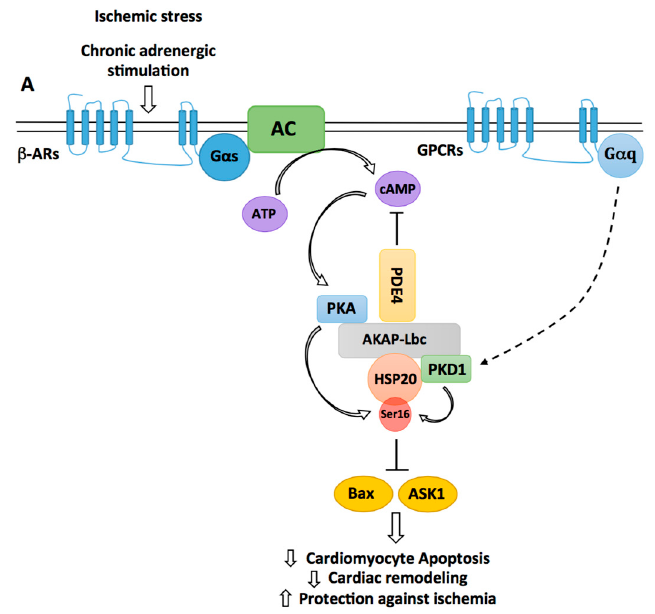
Figure 3. Regulation of HSP20-mediated cardiomyocyte protection by AKAP-Lbc. By recruiting phosphodiesterases 4 (PDE4), AKAP-Lbc maintains a low local concentration of cAMP, which prevents activation of anchored PKA. Chronic β -adrenergic stimulation induces a sustained production of cAMP, which saturates PDE4 and promotes anchored PKA activation. Activated PKA phosphorylates AKAP-Lbc-bound HSP20 on serine 16, an event that has been shown to enhance the cardioprotective function of HSP20. Indeed, phosphorylated HSP20 has been shown to suppress Ask1-dependent signaling and to inhibit Bax leading to reduced cardiomyocyte apoptosis, decreased pathological cardiac remodeling, and increased protection against ischemia. PKD1 can form a complex with HSP20 and promote its phosphorylation on serine 16. The relative contribution of PKA vs. PKD1 to the phosphorylation of HSP20 in vivo remains to be elucidated.